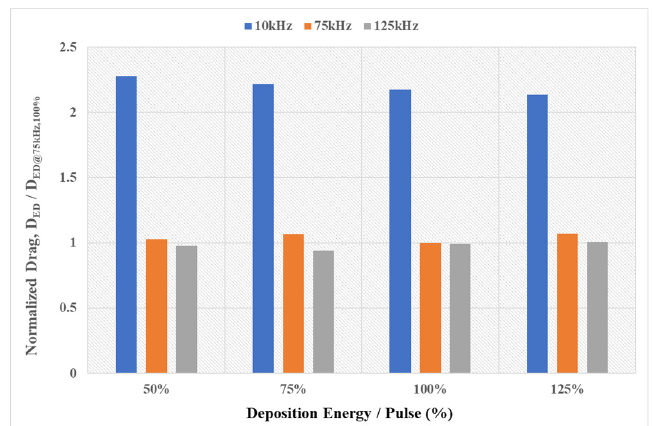
Figure 12. Normalized drag reduction ratio vs. deposition energy per unit time of 75 kHz and 125 kHz.